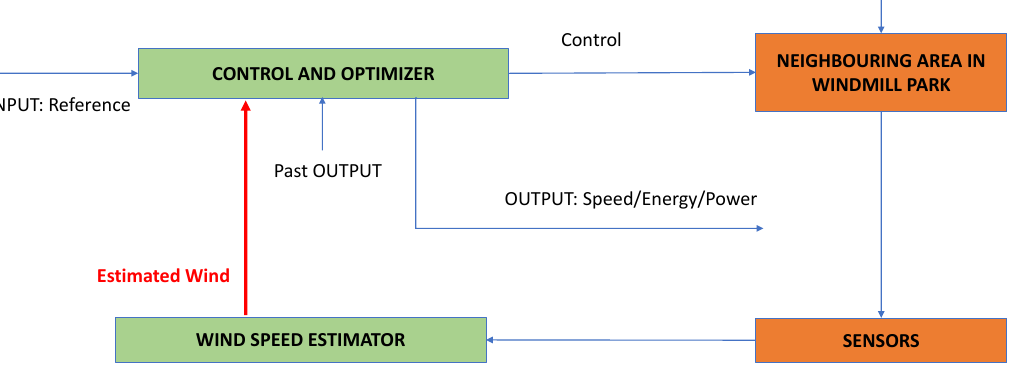
Figure 1. Block scheme with wind estimator and controller on the